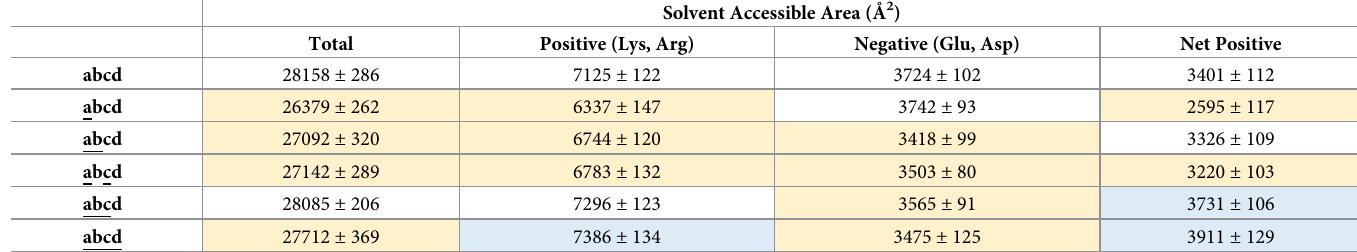
Table 1. Averaged total solvent accessible areas (SAAs) of WT and p.E27K SSBP1 were calculated from the last 100 ns of the molecular dynamics trajectory. The SAAs of positively-charged residues (R and K) and negatively-charged residues (E and D) are also shown, along with the net positively-charged SAA calculated from the difference between positive and negative SAA. Monomers underlined are E27K. Highlight colors reflect differences from the WT tetramer in each category: yellow indi- cates reduction; blue indicates increase. ± reflects standard